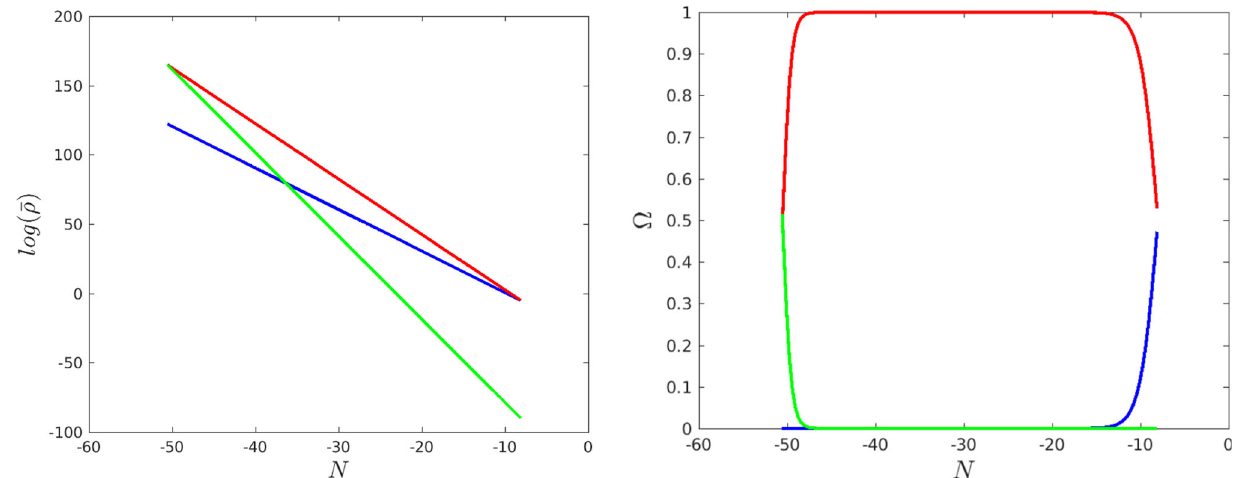
ters (cid:4) m ,(cid:4) r ,(cid:4) ϕ (using the same color code), from reheating to matter- radiation equality have been shown. Note that (cid:4) ϕ, eq << 1